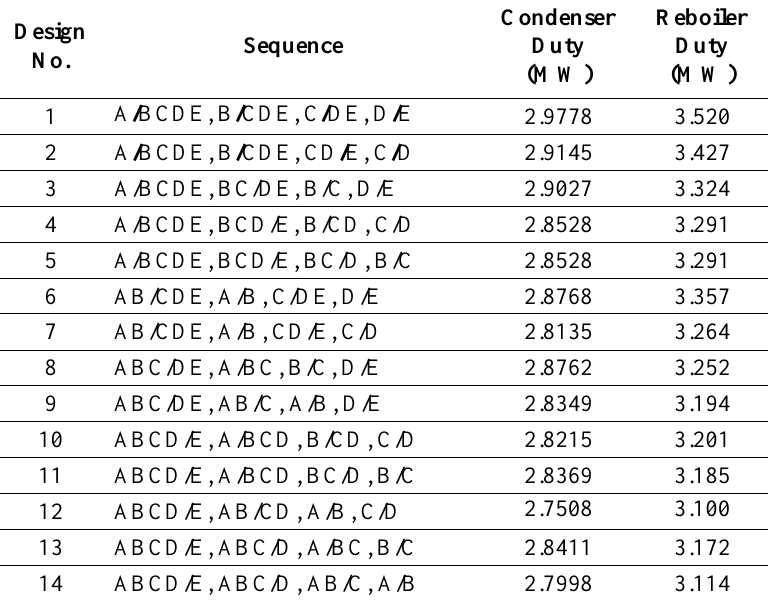
Table 11. Energy consumption at hot & cold utilities used to column